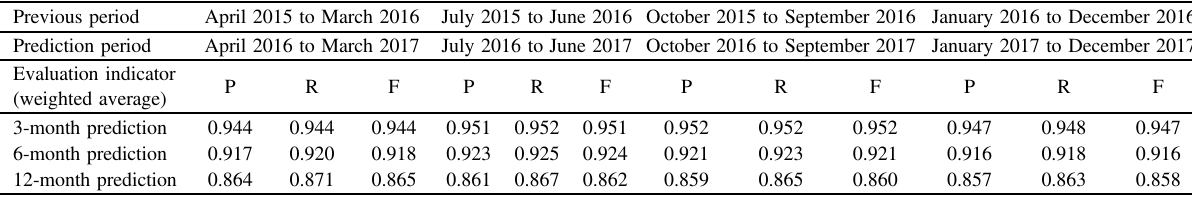
Table 7 Future eligibility level prediction using four di ff erent dataset periods.